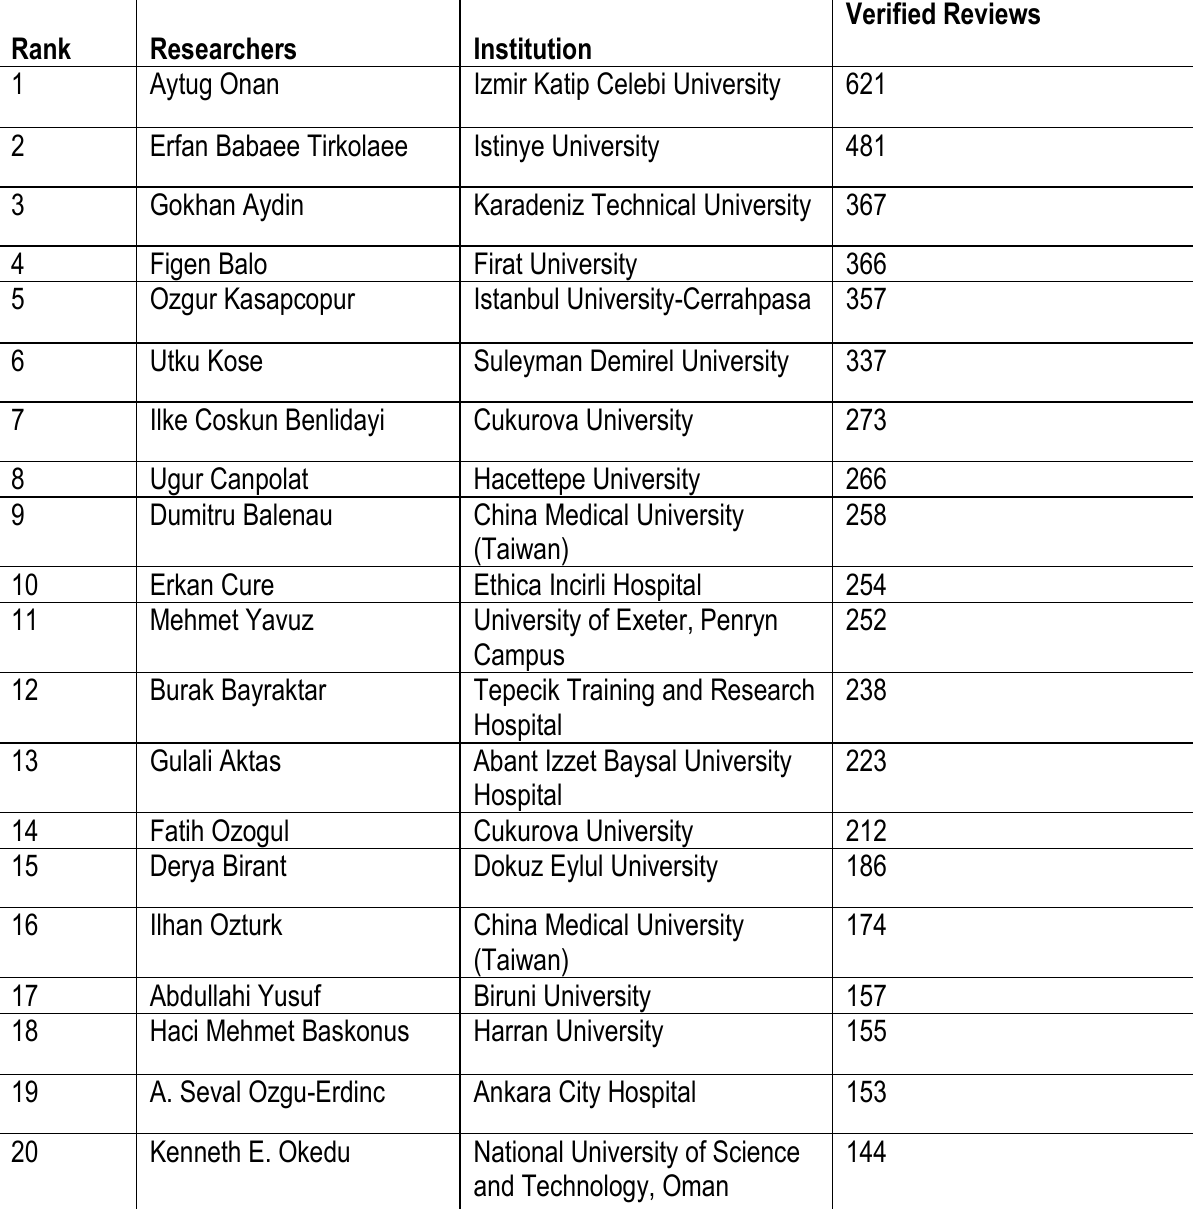
Table 3. Top 20 researchers in terms of the total number of verified reviews in the last 12 months